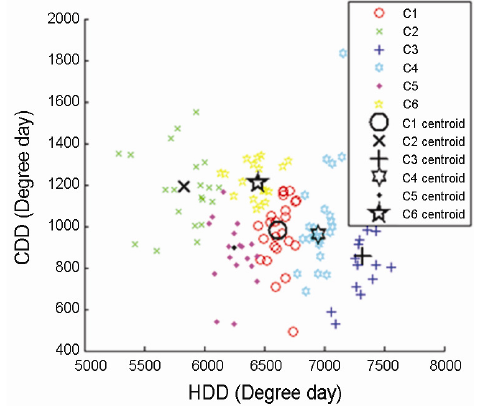
Fig. 12. Degree days clustering (6 classes)